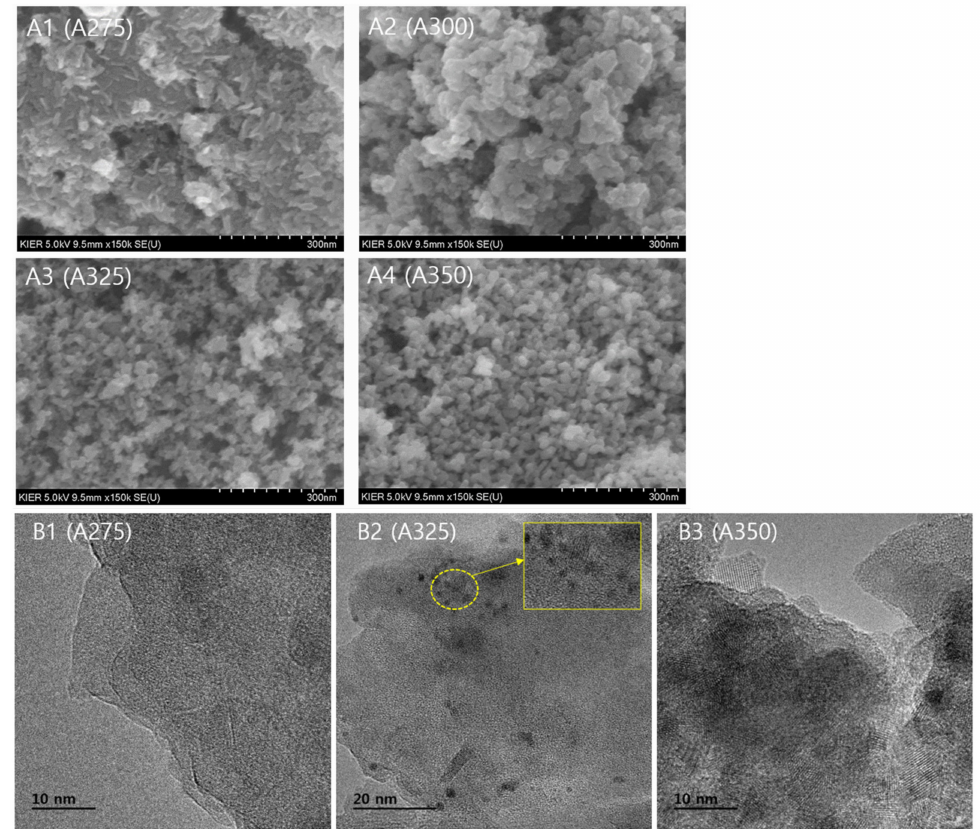
Figure 3. SEM ( A1 – A4 ) and FE-TEM ( B1 – B3 ) images of the alumina samples A275, A300, A325, and